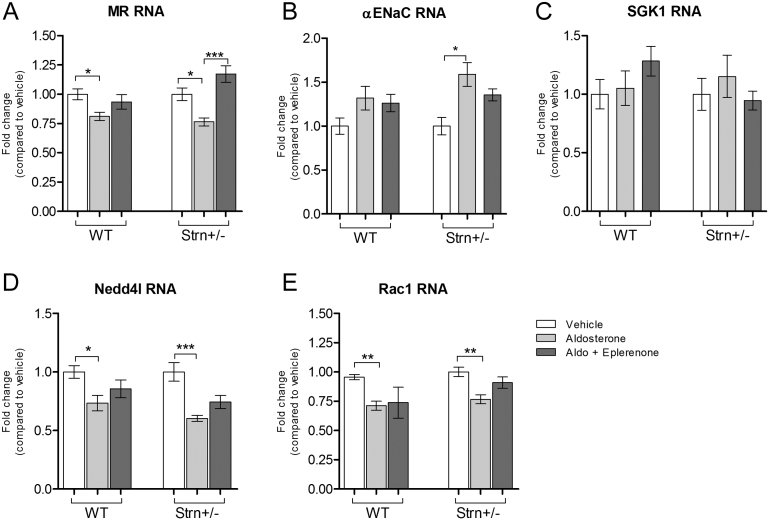
MR genomic markers of renal sodium signaling. (A) MR, (B), αENaC, (C) SGK1, (D) Nedd4l and (E) Rac1 as measured by Nanostring Technologies. n = 5–6. Data presented at mean ± s.e.m. ns = P > 0.05, * = P < 0.05, ** = P < 0.01, ***P < 0.001.